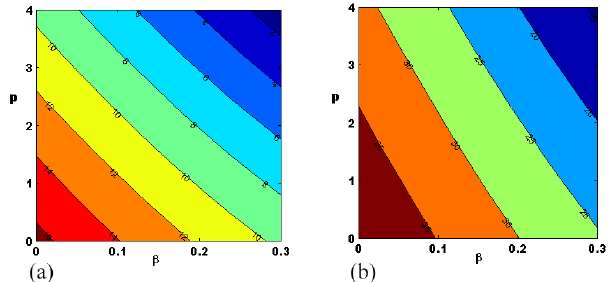
Figure 7. Contour plot of q 2 with respect to β and p with µ = 0 . 1, (a) SS, (b)